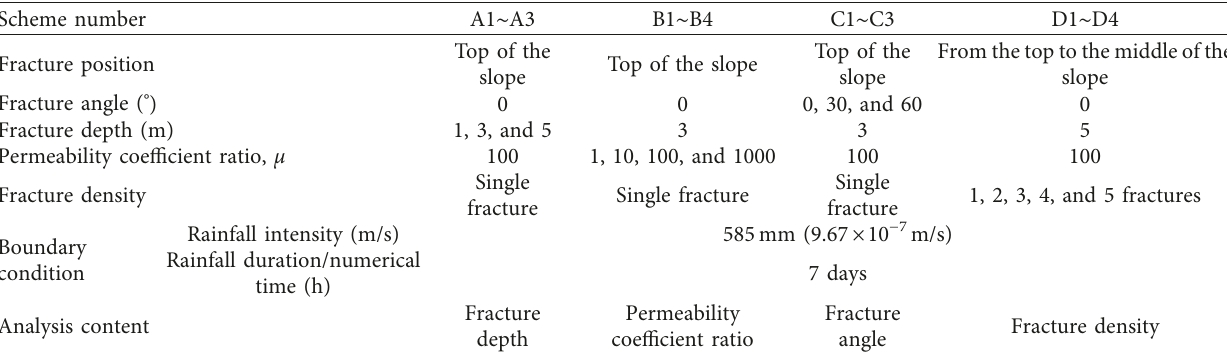
Figure 4: Fracture permeability coefficient in the global coordinate Table 1: Schemes for numerical analysis.